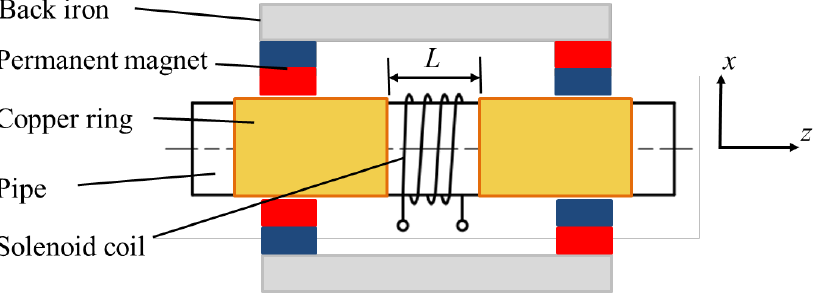
Figure 7. The special structure of the transmitter for the longitudinal guided wave testing.